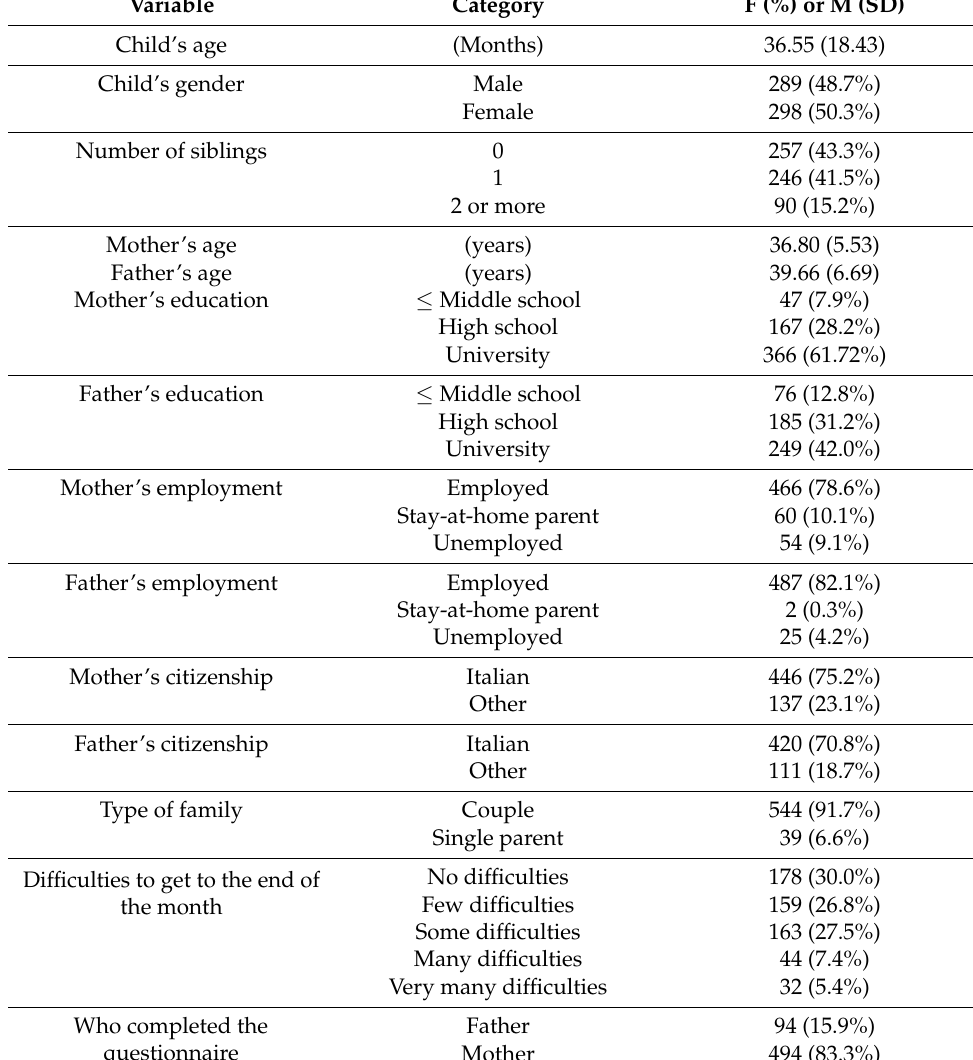
Table 3. Participants’ characteristics (Study 2).